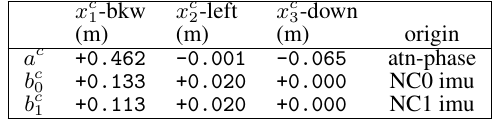
Table 1. Lever-arm values of antenna-phase center a c , and imu-body navigation centers b c 0 , b c 1 in the